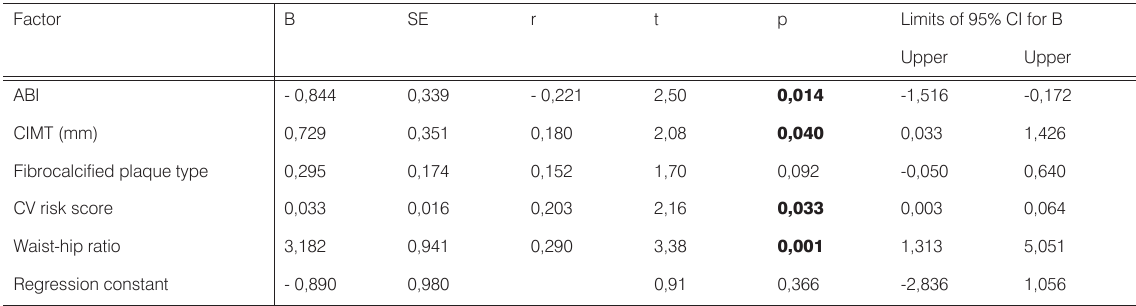
Table 3. Evaluation of the association of investigated parameters and the number of affected coronary blood vessels: results of mutivariate regression analysis Factor